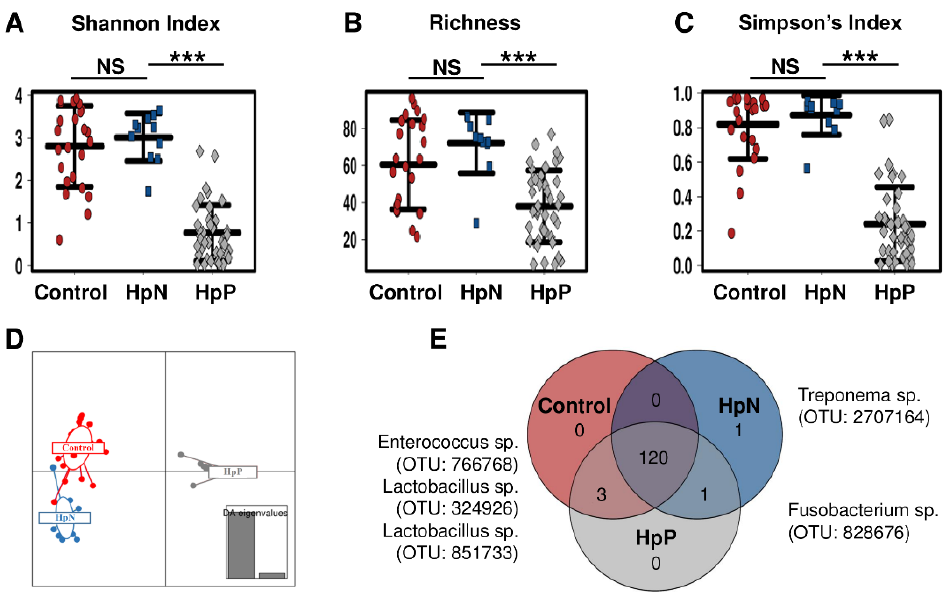
Figure 1. Alpha diversity and unique taxonomy by comparison groups. Shannon index ( A ); bacterial richness ( B ); Simpson’s index ( C ); ( D ) discriminant analysis of principal components (DAPC); ( E ) Venn diagram for overall operational taxonomic units (OTU) taxonomy are shown according to HpN, HpP and control groups. Venn diagram based on the absence or presence of taxonomies showed 120 species were core, four species were pan and one species were determined as unique taxonomy among comparison groups. NS: not significant, *** p < 0.001.